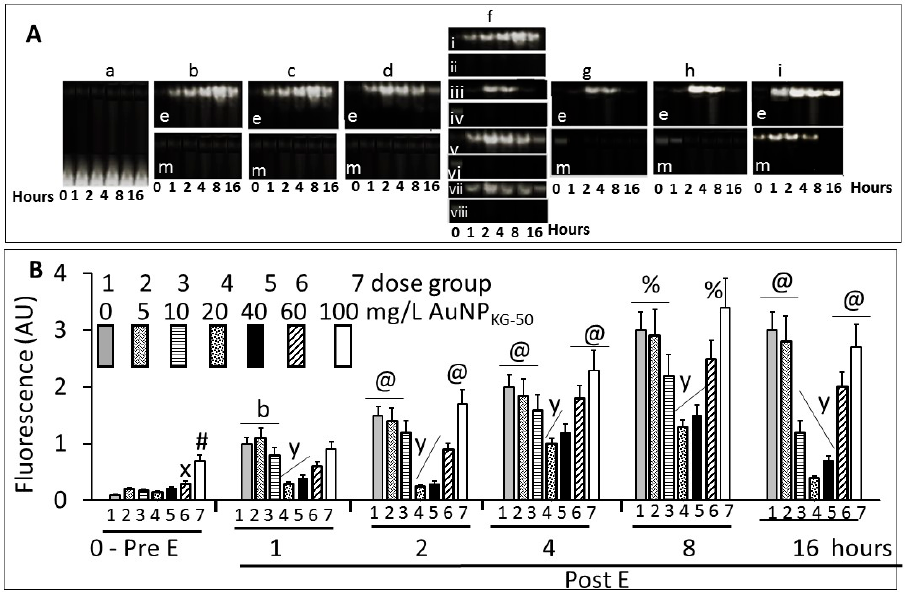
Figure 14. ( A ) Typical electrophoretic separation of NF κ B dimer, p65–p50, in An/En (matrix), An/Ep (E+matrix), Ap/Ep (E+ 5 to 100 mg/L, data for AuNP KG-50 is shown), and Ap/En (saline + 5 to 100 mg/L, data for AuNP KG-50 is shown) cells. [a] matrix exposed control, An/En cells, [be] AuNP negative but ethanol positive An/Ep cells, [bm] AuNP and ethanol negative An/En cells, [ce] Ap/Ep cells receiving 5 mg/L AuNP KG-50 , [cm] Ap/En cells receiving 5 mg/L AuNP KG-50 , [de] Ap/Ep cells receiving 10 mg/L AuNP KG-50 , [dm] Ap/En cells receiving 10 mg/L AuNP KG-50 , [f] Ap/Ep cells receiving 20 mg/L AuNP PEG+K+G (fi), AuNP KG-50 , (fiii), AuNP K-50 (fv) and AuNP G-50 (fvii), and [ge, he, ie] Ap/Ep cells receiving 40, 60, and 100 mg/L, respectively, and [gm, hm, im] Ap/En cells receiving 40, 60, and 100 mg/L, respectively; ( B ) Scan of the p65–p50 fluorescence—dose–response and time course studies. (0 –Pre E) Ap/En cells were exposed to different doses of AuNP KG-50 . (1 to 16 days post ethanol exposure): Ap/Ep cells were exposed to different doses of AuNP KG-50 for 4 days then ethanol for 24 h. Cells were analyzed at day 1, day 2, day 4, day 8 and day 16 post ethanol. Values are mean ± SD. x: p < 0.05 when values for cells exposed to 60 mg/L were compared with cells exposed to lower AuNP doses. #: p < 0.05 when values for cells exposed to 100 mg/L were compared with cells exposed to lower AuNP doses. b: p < 0.05 when values for cells exposed to 0, 5, and 10 mg/L were significantly higher than the values for cells exposed to higher doses. y: p < 0.05 when values for cells exposed to 20 and 40 mg/L were compared with other values. @: p < 0.05 when values for same AuNP dose collected at different time intervals were compared. Values are mean ± SD, n = 5.